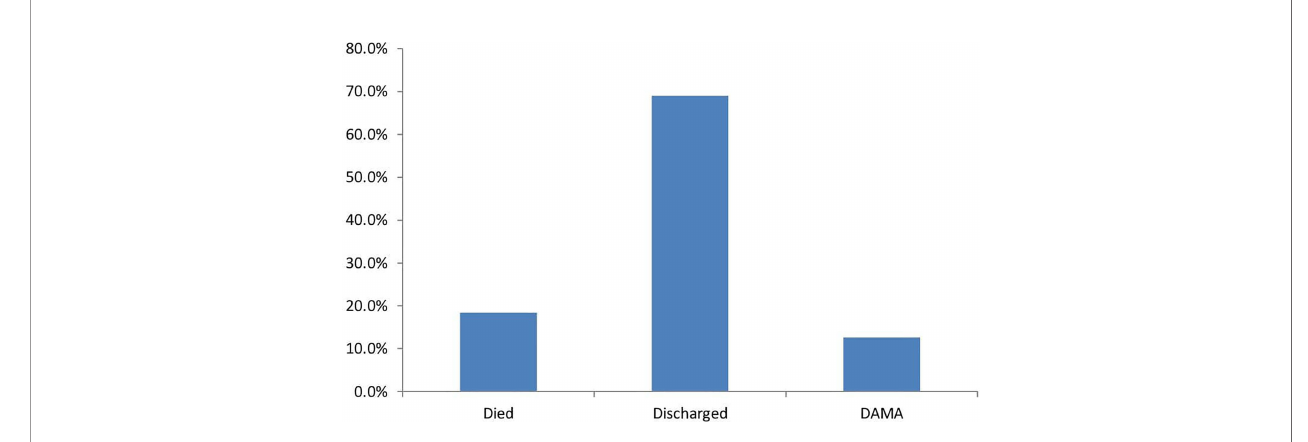
FIGURE 3 | Outcome of